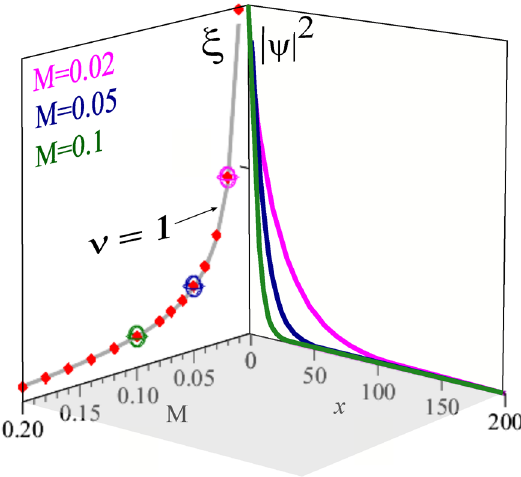
Figure 3. Decay of the probability density in the bulk and the penetration depth ξ to the critical point. In the plane x along x direction, for the distances to the critical point M lines, respectively. From these plots we can extract ξ these values of the correlation length (red diamonds) as a function of the distance to the critical point M and note that this is well described by ξ the same color scheme of the plane x